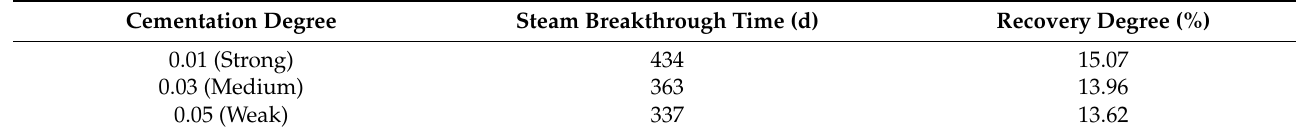
Table 6. Steam breakthrough time and recovery degree for different cementation degree.